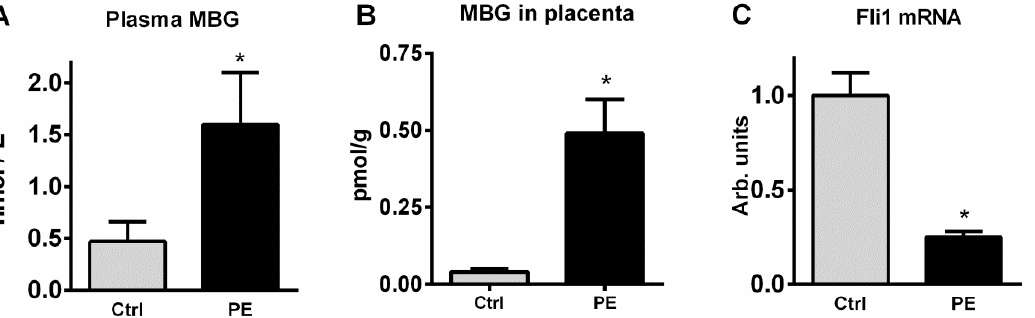
Figure 2. Plasma ( A ) and placental ( B ) levels of MBG, and mRNA levels of Fli1 in placenta ( C ) in subjects with uncomplicated pregnancy (Ctrl) and from patients with preeclampsia (PE). By two-way Student’s test: * p < 0.01 vs. Ctrl.